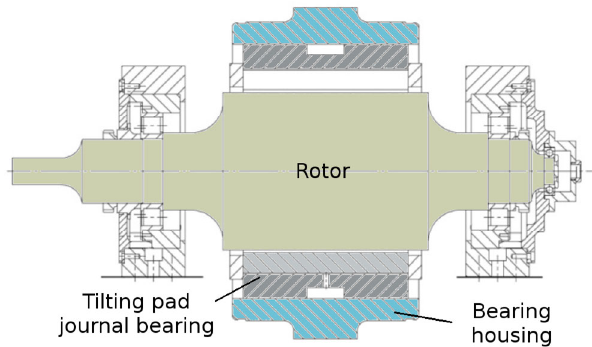
Fig. 2 Schematic of test zone with tilting pad journal bearing.